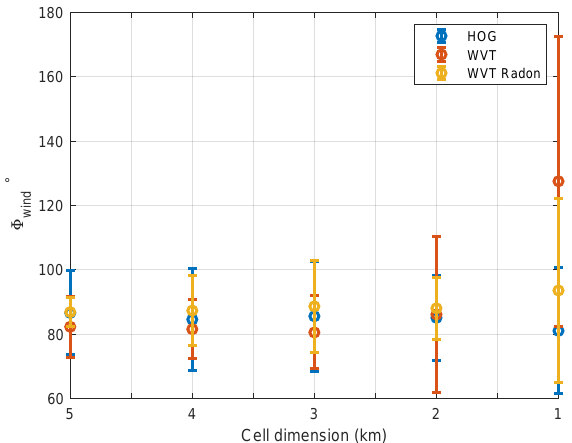
Figure 15. Estimated wave directions in function of cell dimensons for the class C 1